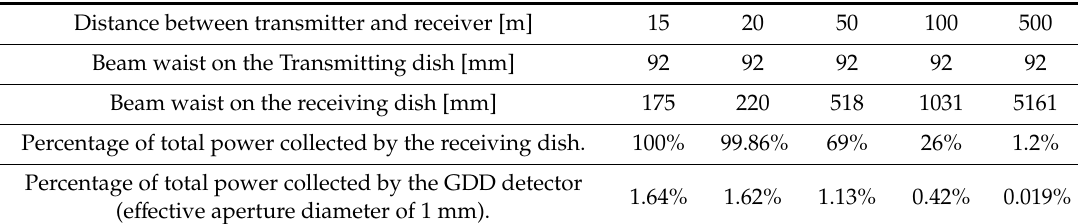
Table 1. Approximated beam diameter and approximated percentage of total power collected by the receiving dishes are given for transmitter to receiver distances of z = 15 m, z = 20 m, z = 50 m and z = 500 m. Distance between transmitter and receiver [m] 15 20 50 100 500 Beam waist on the Transmitting dish [mm] 92 92 92 92 92 Beam waist on the receiving dish [mm] 175 220 518 1031 5161 Percentage of total power collected by the receiving dish. 100% 99.86% 69% 26% 1.2% Percentage of total power collected by the GDD detector 1.64% 1.62% 1.13% 0.42% (e ff ective aperture diameter of 1 mm).